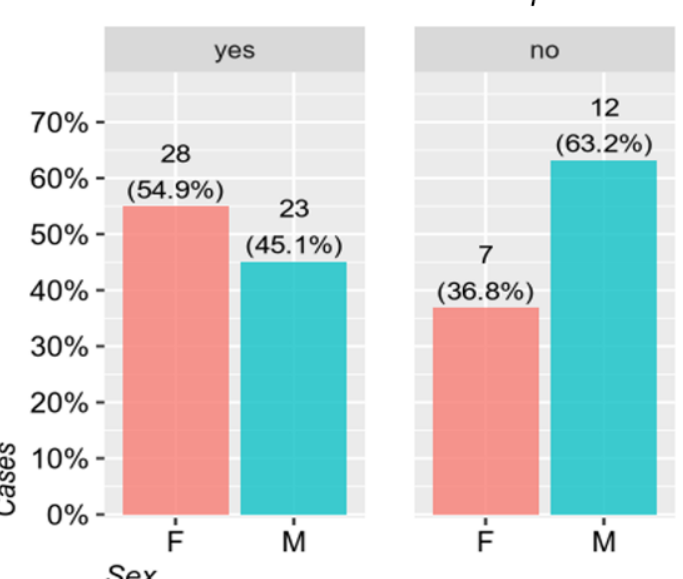
Figure 1. The relationship between the presence of LBBB and the normal coronary arteries between the two sexes. F—females, M—males.